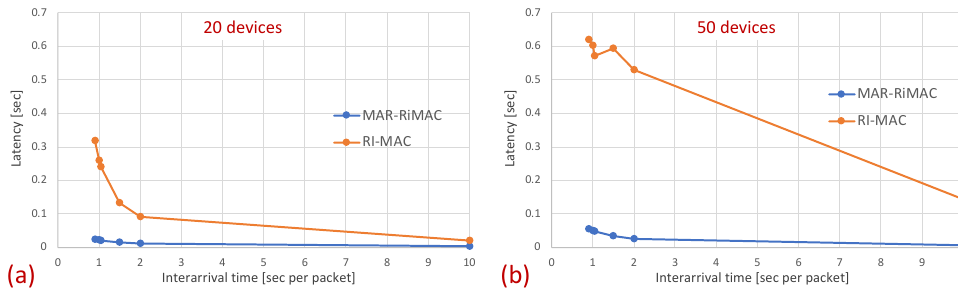
Figure 15. Hidden-terminal topology: The average latency experienced by the packets from the time that both the transmitting device and the sink are awake until the successful reception of the packet by the sink for: ( a ) 20 devices; ( b ) 50